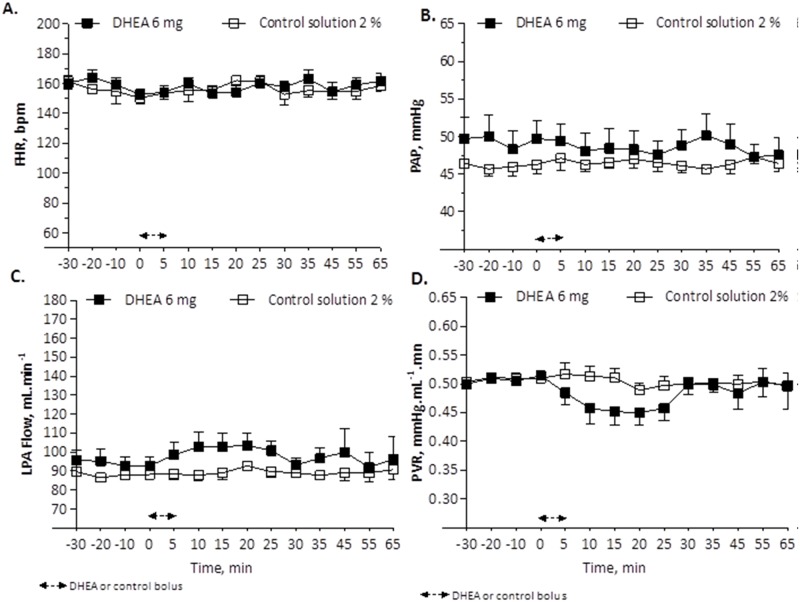
Change in fetal heart rate, FHR (A), pulmonary artery pressure, PAP (B), left pulmonary artery blood flow, LPA flow (C) and pulmonary vascular resistance, PVR (D) in response to bolus of 6 mg DHEA compared to bolus of control solution 2%.Values are means ±SEMs, n = 5, (DHEA 6 mg) and n = 5, (control 2%).